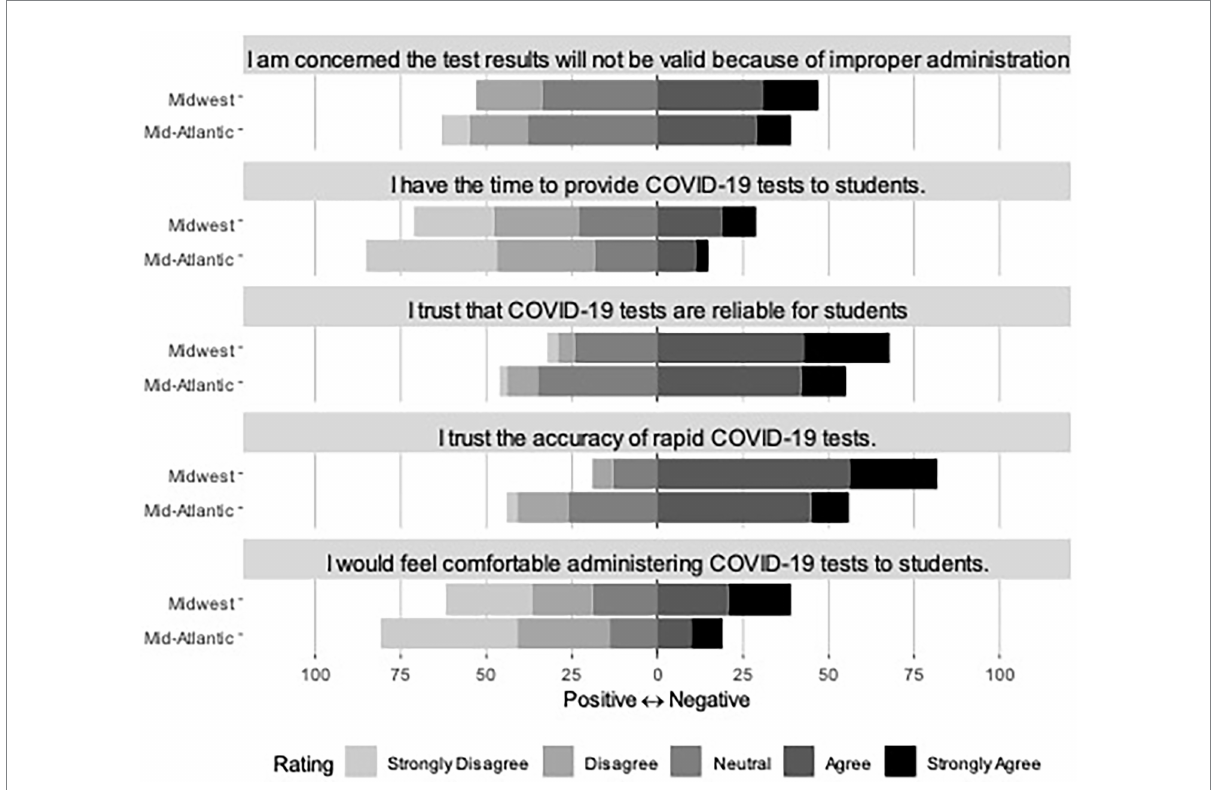
FIGURE 3 Educator perceptions of COVID-19 testing in the school system. Items rated on a 5-point Likert scale from Strongly Disagree to Strongly